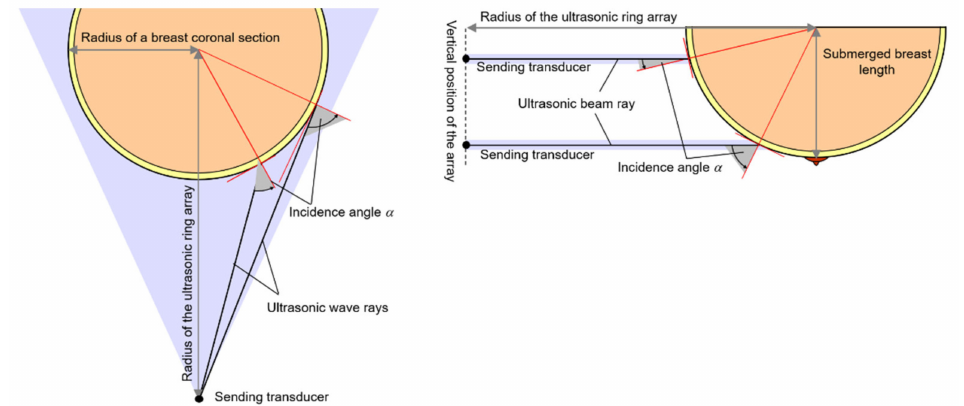
Figure 13. Geometric computational models for investigating the area of greatest refraction of an ultrasound wave in a cross-section of a breast submerged in water, inside a ring array, successively in the horizontal and vertical